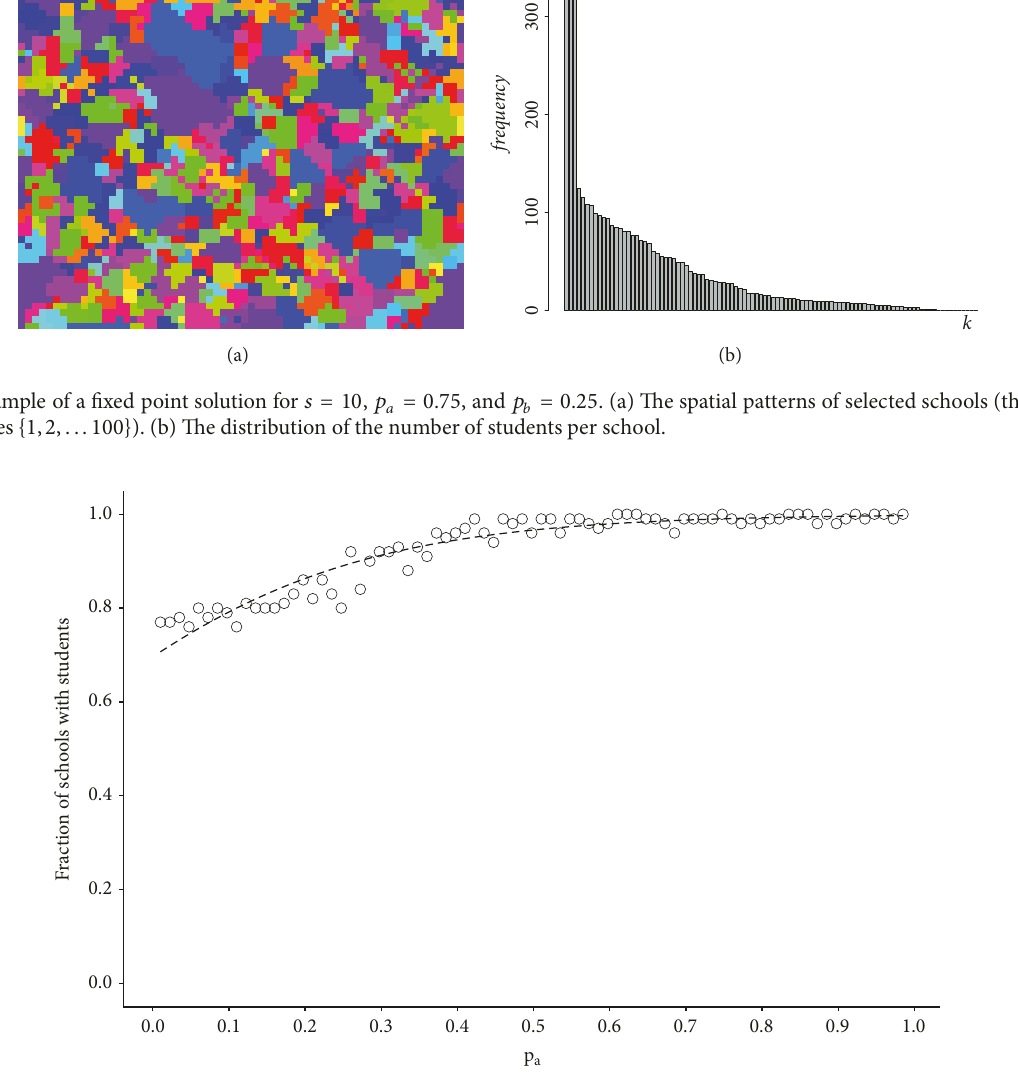
Figure 6: The fraction of schools with students for different values of 𝑝 𝑎 , under the social expectations